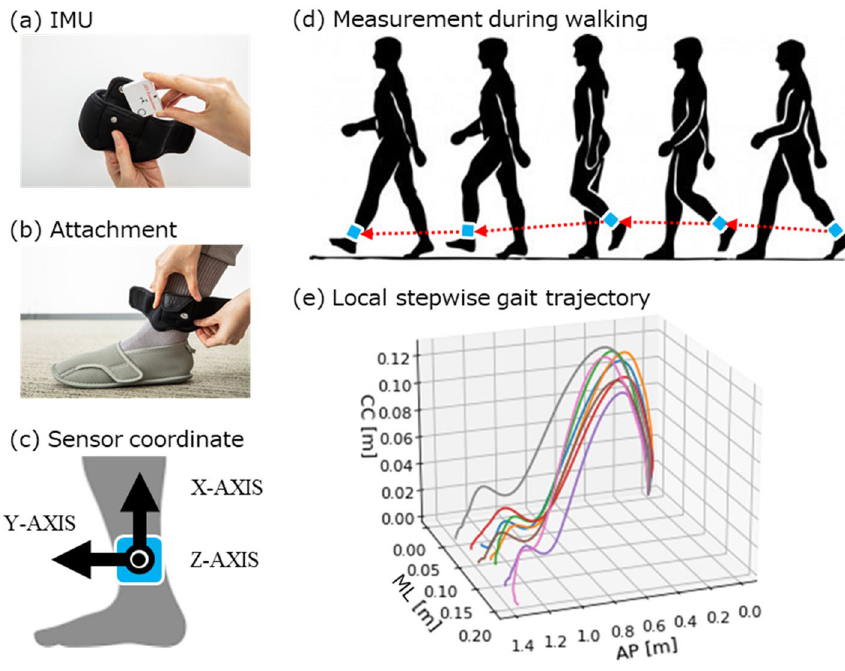
Figure 8. Outline of system setup in proposed method and example of local stepwise gait trajectory. ( a ) IMU sensor and an attachment equipment. ( b ) Attachment of the IMU sensor to the outside of the shank. ( c ) Setup of sensor coordinate system of the IMU sensor. The X, Y, and Z axes was set to craniocaudal direction, anterior– posterior direction, and medial–lateral direction. ( d ) Measurement of IMU data on the shank during walking. ( e ) Estimation example of local stepwise gait trajectory with IMU data on the shank during walking. In the axes, AP means anterior–posterior direction, ML means medial–lateral direction, and CC means craniocaudal direction.